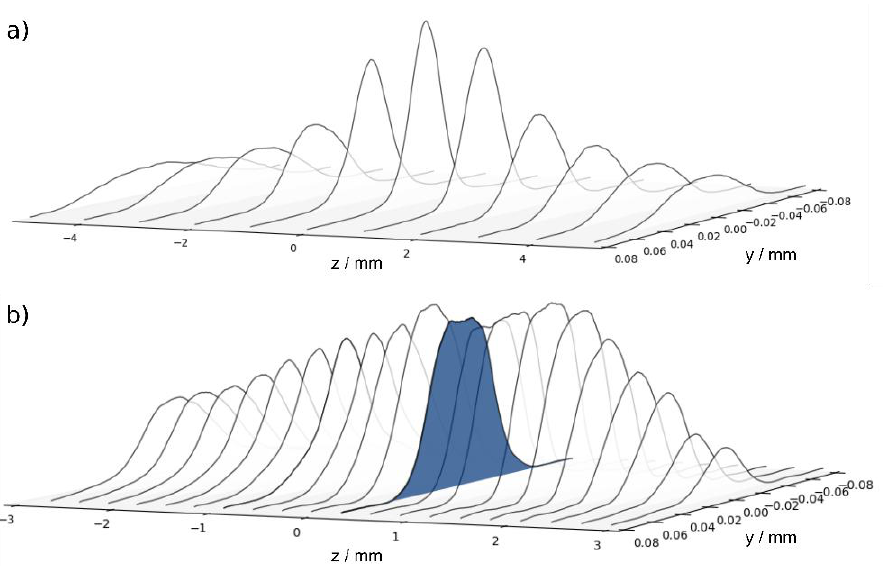
Figure 3. Profile cross-sections measured along the optical axis (z) in the focal region ( a ) without and ( b ) with freeform beam-shaping element.